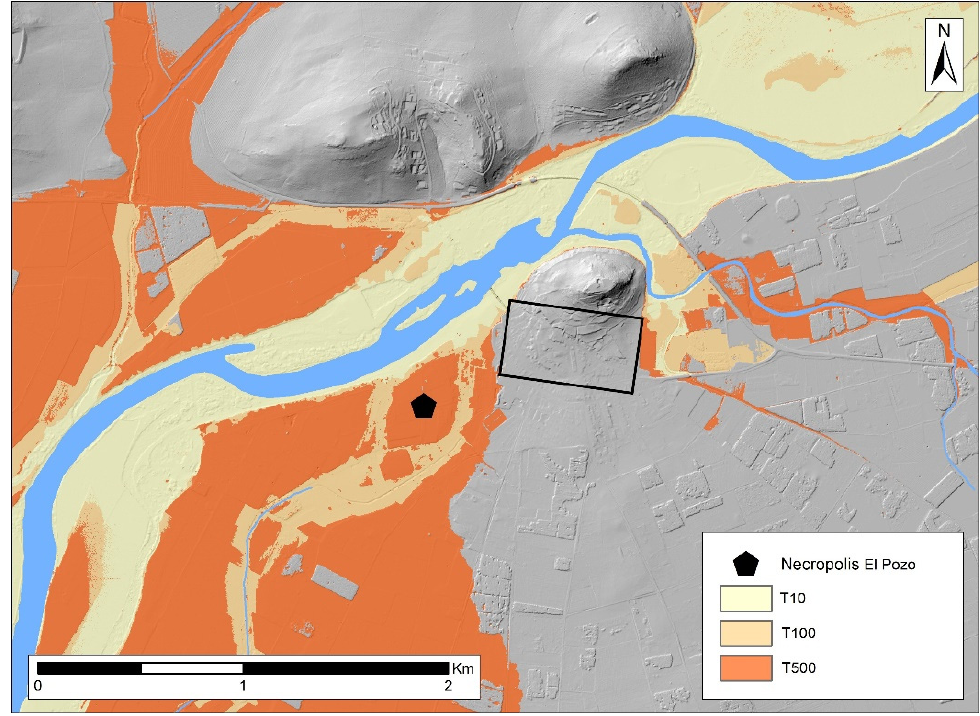
Figure 13. Cartography showing the hypothetical location of the first Iron Age settlement of Medel- lín, marked with a black rectangle (Badajoz, Spain).